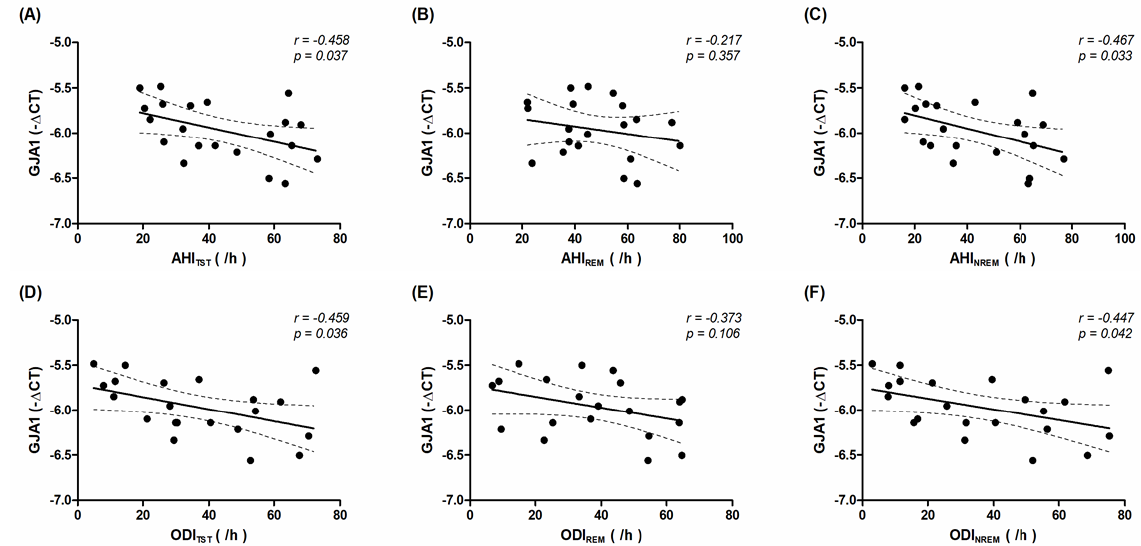
Figure 3. Correlation between GJA1 gene expression in HL-1 cells and the apnea-hypopnea index (AHI) and oxygen desaturation index (ODI) during total sleep time (TST), rapid eye movement (REM), and non-rapid eye movement (NREM) periods in obstructive sleep apnea syndrome patients with atrial fibrillation (AF). The point in the plot is the observation. The solid line indicates the fitted linear regression line, and its 95% confidence interval is the area enclosed by the dashed curves. The r - and p -values indicate the correlation between the expression of GJA1 (expressed as − ∆ Ct value) and ( A ) AHI TST , ( B ) AHI REM , ( C ) AHI NREM , ( D ) ODI TST , ( E ) ODI REM , ( F ) ODI NREM (expressed as number per hour).